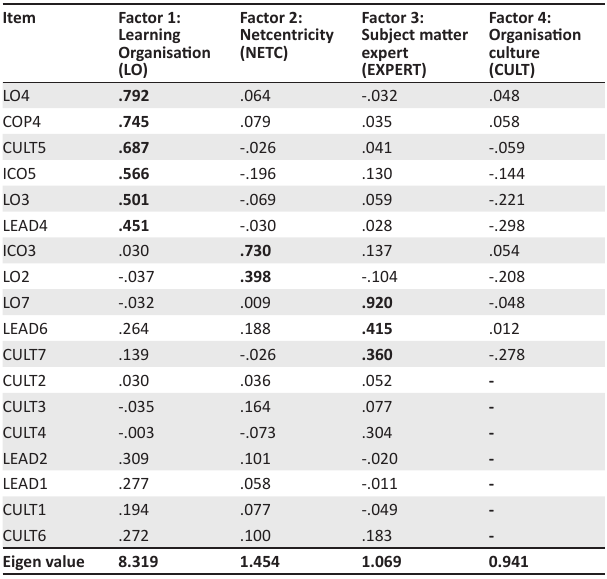
TABLE 1: Rotated factor loadings: Organisational variables.